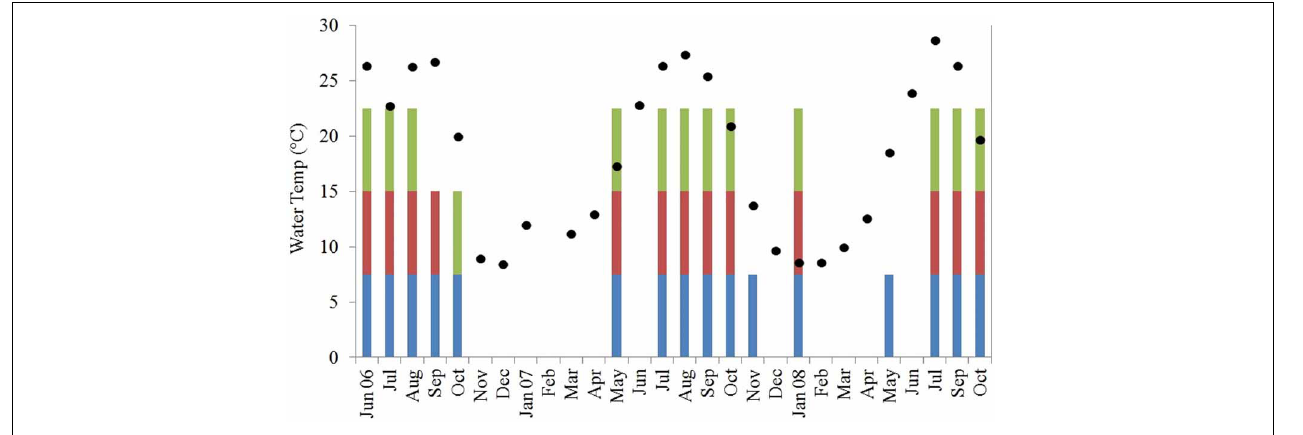
FIGURE 2 | Water temperature in degrees C (black diamonds, Y-axis) and V. parahaemolyticus detection in water (blue bars) and plankton [200 µ m (green bars) and 64 µ m (magenta bars)]. Water temperature is